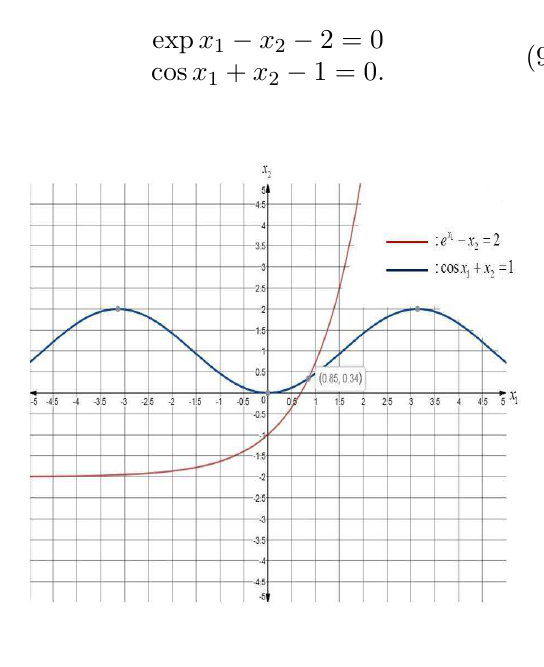
Figure 2. The graph of Example 3.